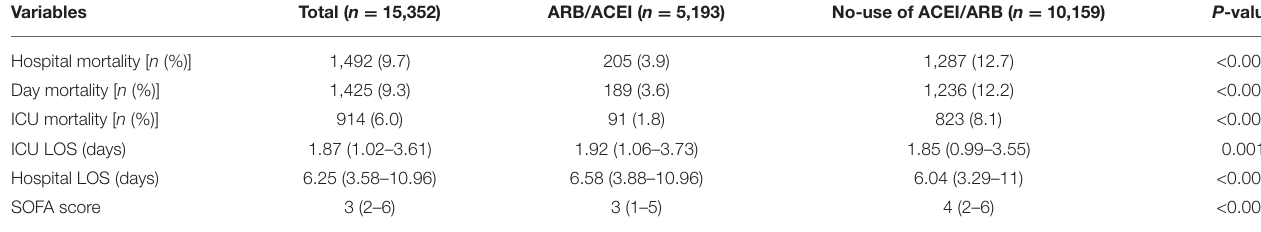
TABLE 2 | Unadjusted outcomes in critically ill patients with hypertension treated with or without ACEI/ARB. Variables